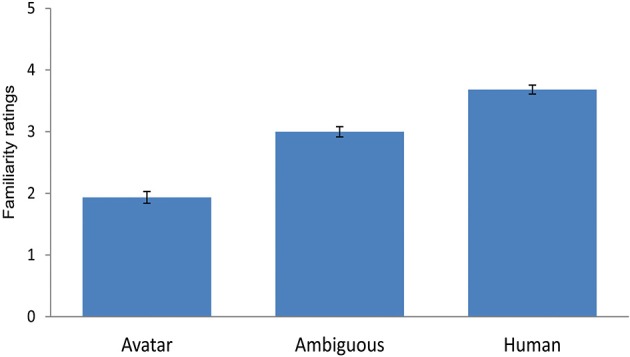
Results of self-rating task for familiarity. Overall, the figure illustrates a general increase in self-rated feelings of strangeness with decreasing human likeness from the human end of the continua. There is no indication of the uncanny effect predicted in the UVH. The error bars indicate 1 SE (N = 49).